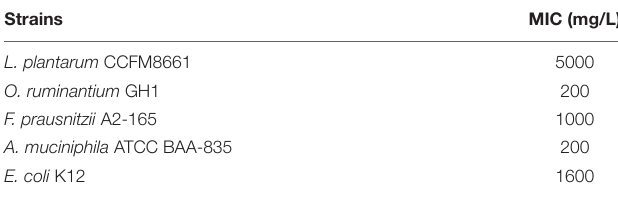
TABLE 5 | Pb tolerance abilities of the tested Pb-sensitive